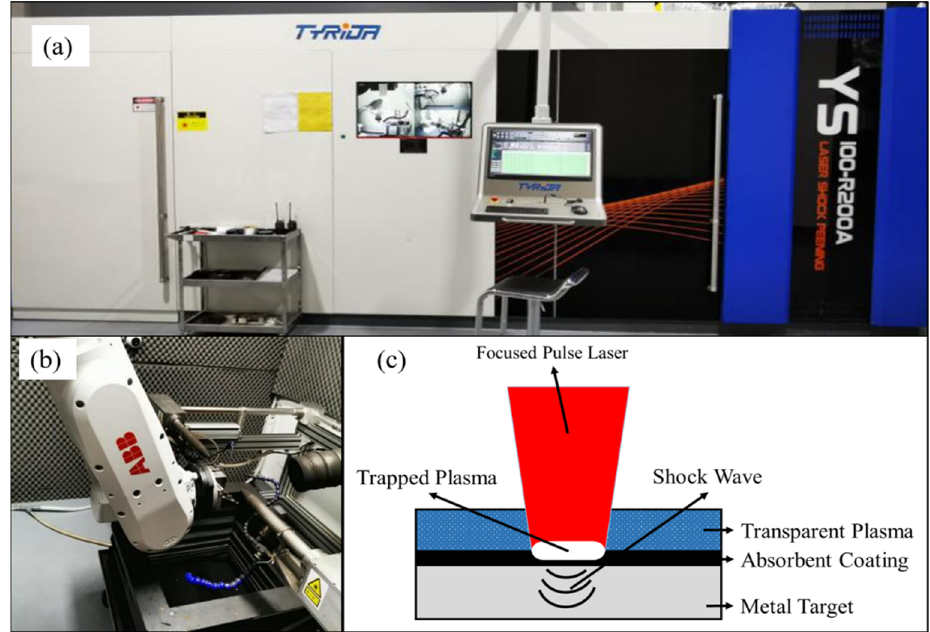
Figure 2. ( a ) LSP equipment, ( b ) LSP process, ( c ) schematic illustration of LSP treatment on sample surfaces.